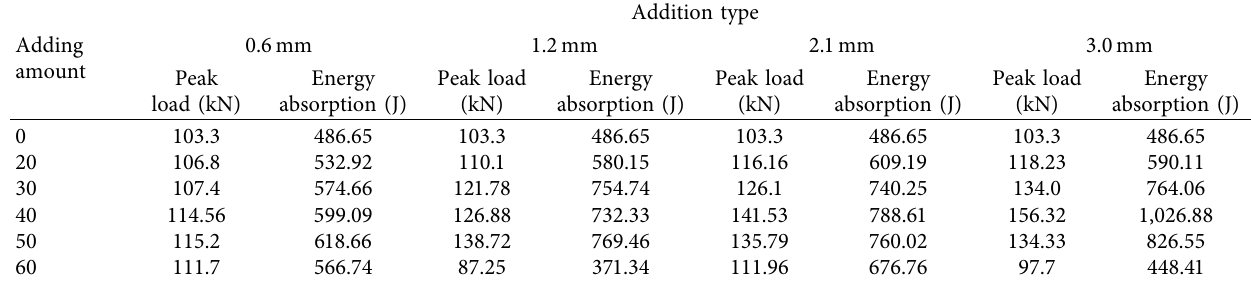
Table 5: Average peak load and energy absorption capacity of each